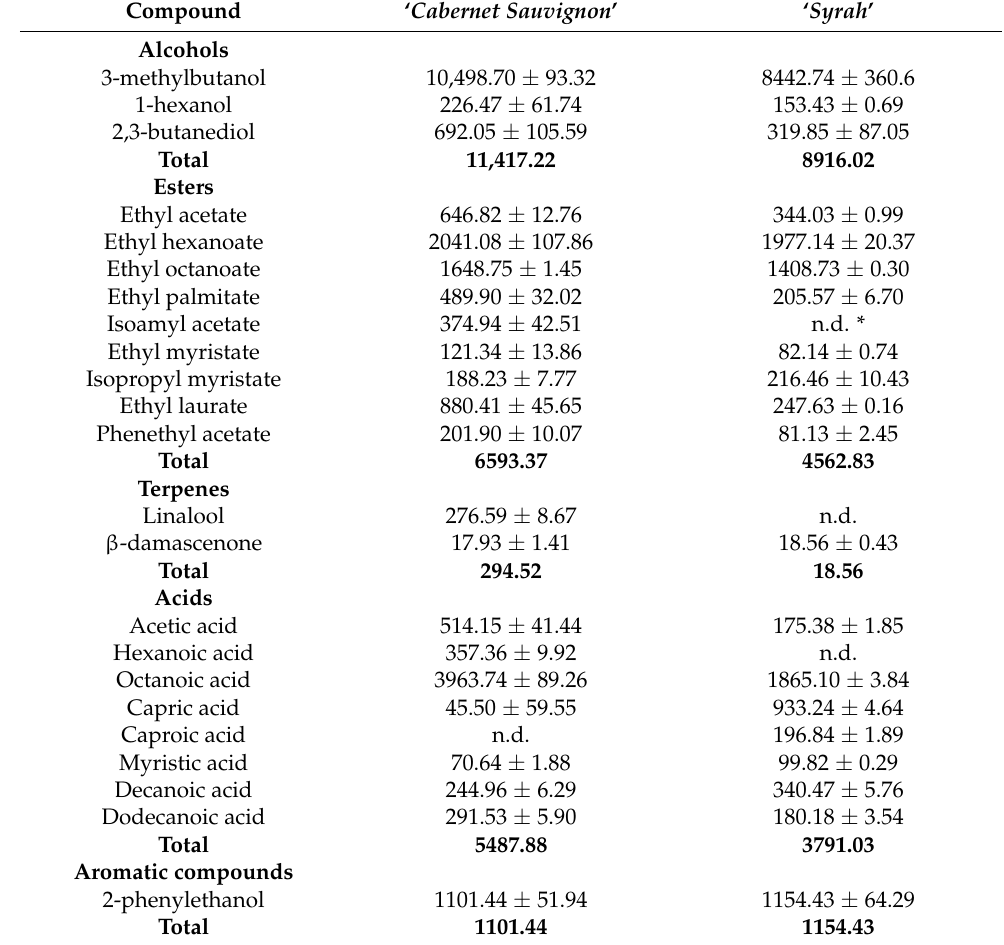
Table 5. Volatile compounds ( µ g/L) identified in ‘ Cabernet Sauvignon ’ and ‘ Syrah ’ base wines.